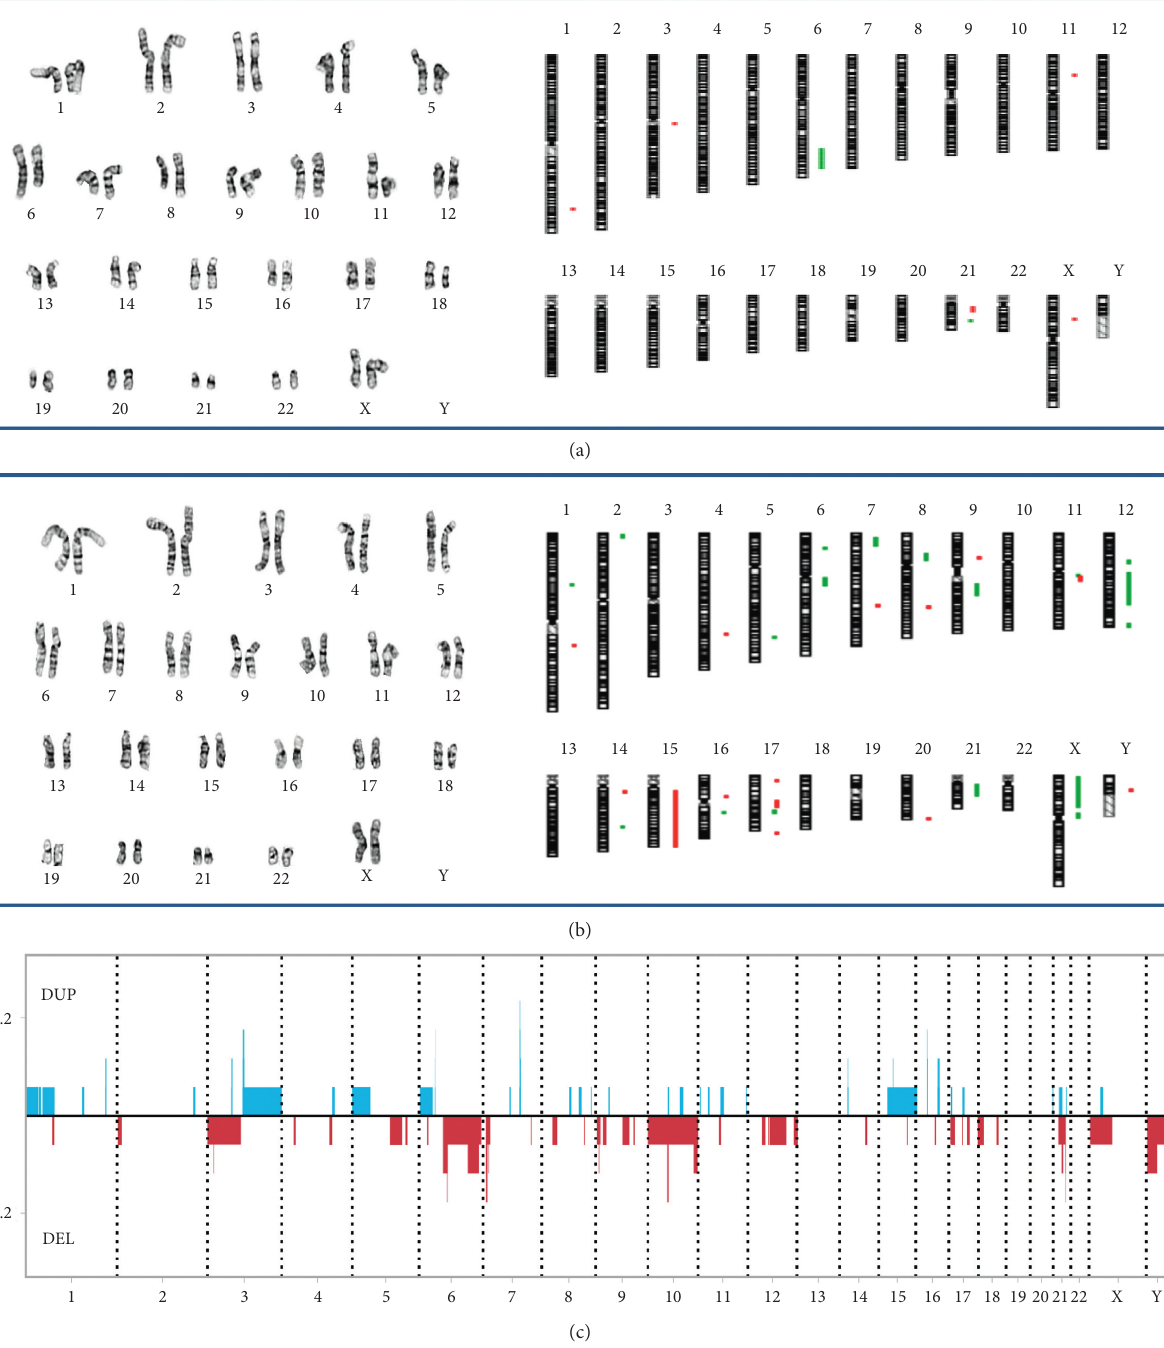
Figure 1: Cytogenomic abnormalities detected in 19 cases of SGTs. (a) For case 4, representative karyotype showed an abnormal clone with a deletion in the long arm of chromosome 6 and a paracentric inversion in the long arm of chromosome 8 (left); genome view by aCGH showed CNAs of deletions of 6q and 21q and duplications of 1q, 3q, 11p, 21q, and Xp (right, green bar for deletion and red bar for duplication). (b) For case 7, chromosome analysis showed a normal female karyotype (left); aCGH genome view showed numerous CNAs in multiple chromosomes (right). (c) The distribution of CNAs detected from 14